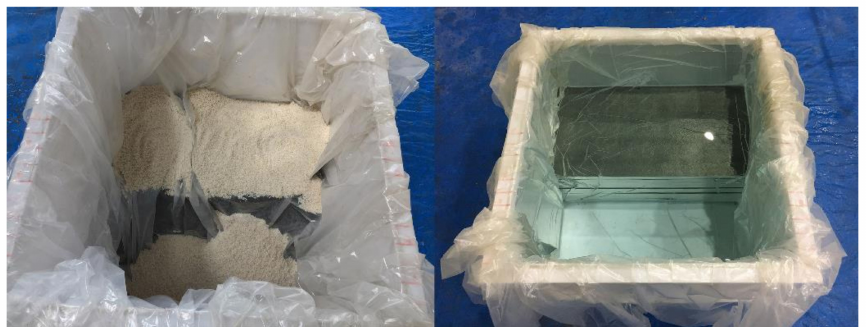
Figure 12. Salt aqueous solution for experiment.